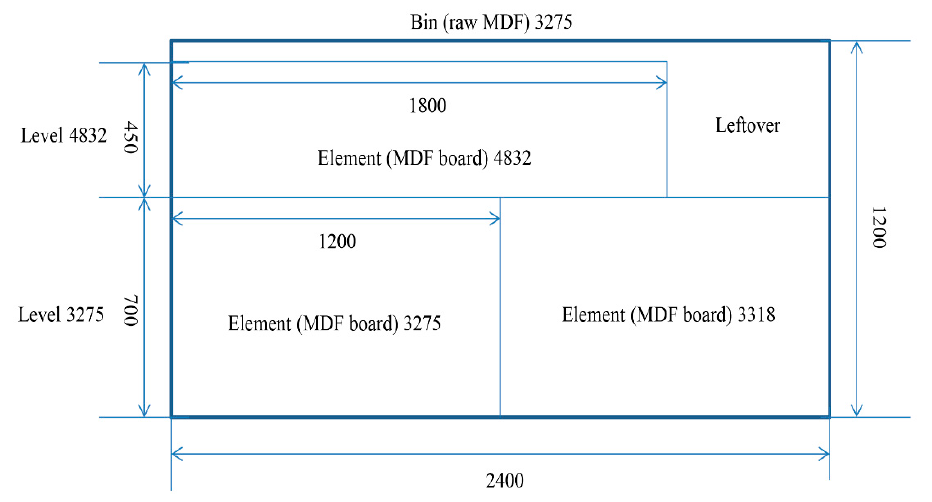
Figure 1. Interpretation of level packing / cutting result for bin (raw MDF) 3275.